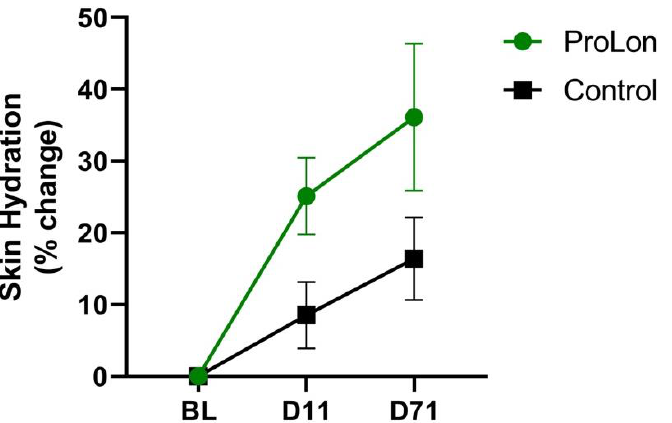
Figure 2. Percent change in skin hydration using corneometer measurements at baseline (BL), day 11 (D11), and day 71 (D71).